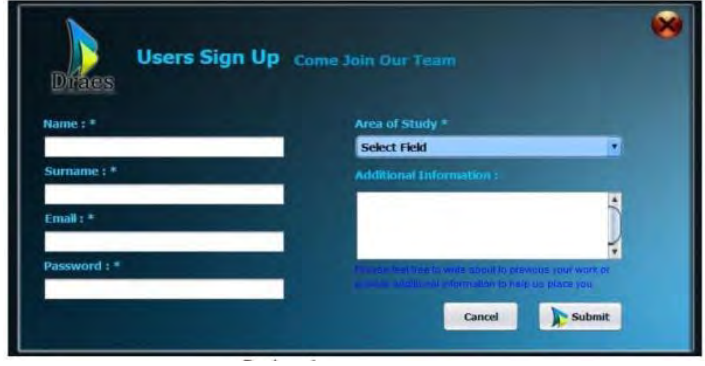
Figure 3. User Registration